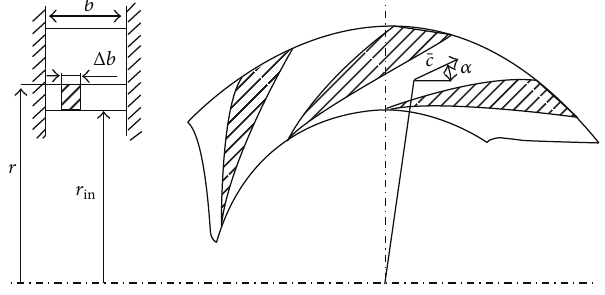
Figure 2: Channel diffuser